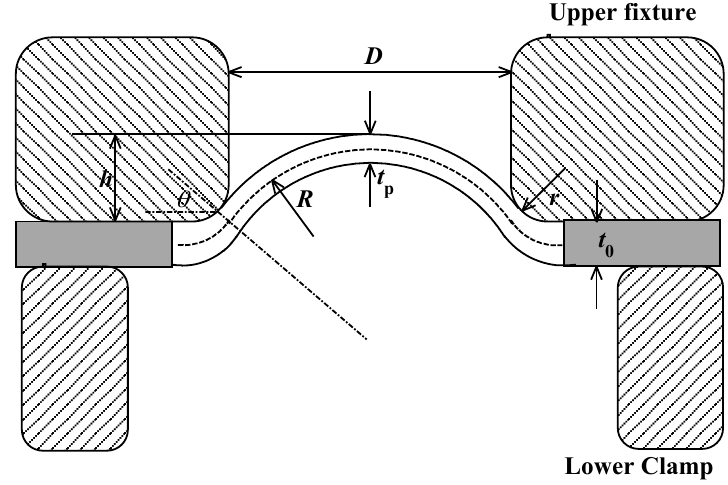
Figure 6. The mechanical model for ultimate tensile strength.